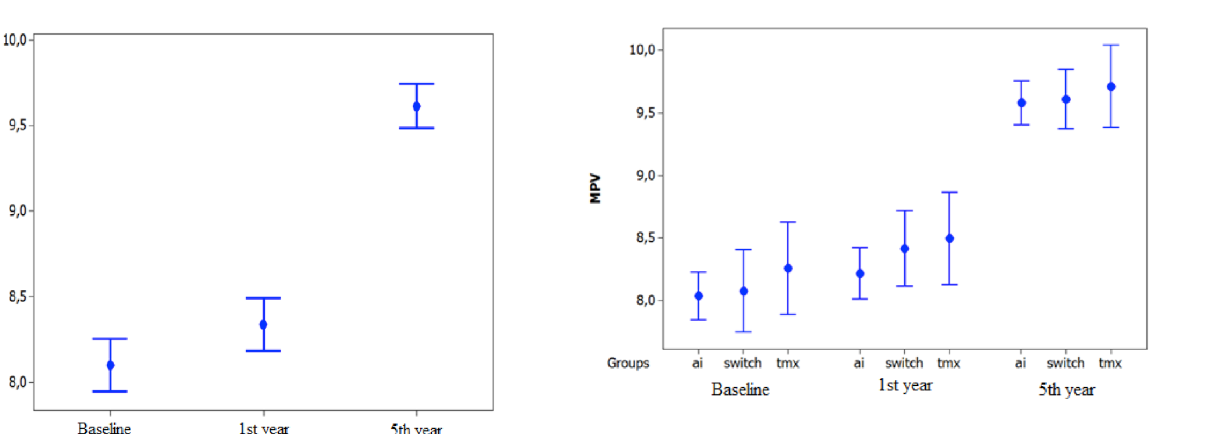
Figure 1A: Mean platelet volume (MPV) at baseline and at the first and fifth years of hormone therapy in all patients